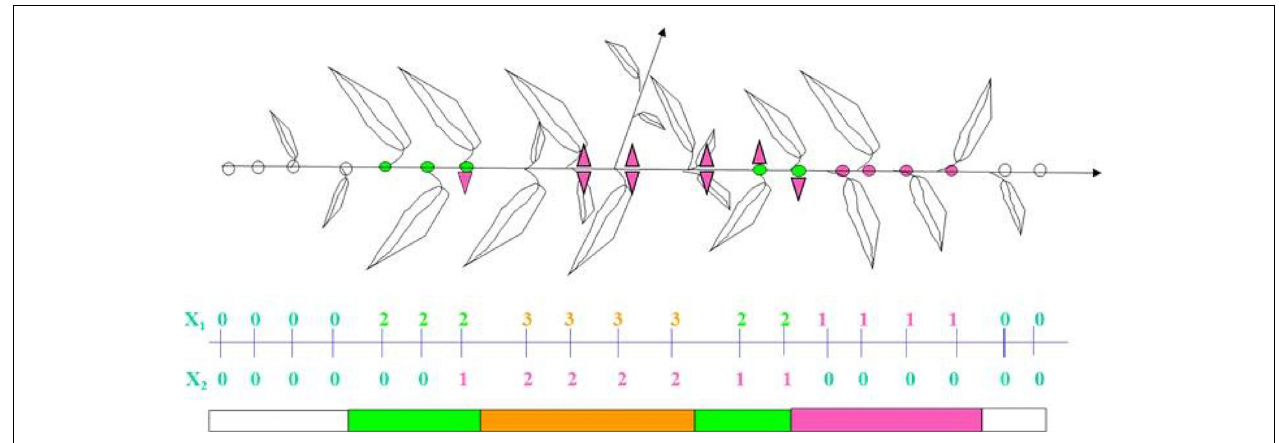
FIGURE 2 | Branching pattern along a peach annual shoot, “Robin” cultivar. First variable: 0 latent bud, 1 isolated floral bud, 2 vegetative bud, 3 sylleptic shoot. Second variable: number (0, 1, 2) of axillary flowers and schematic representation of the shoot as a